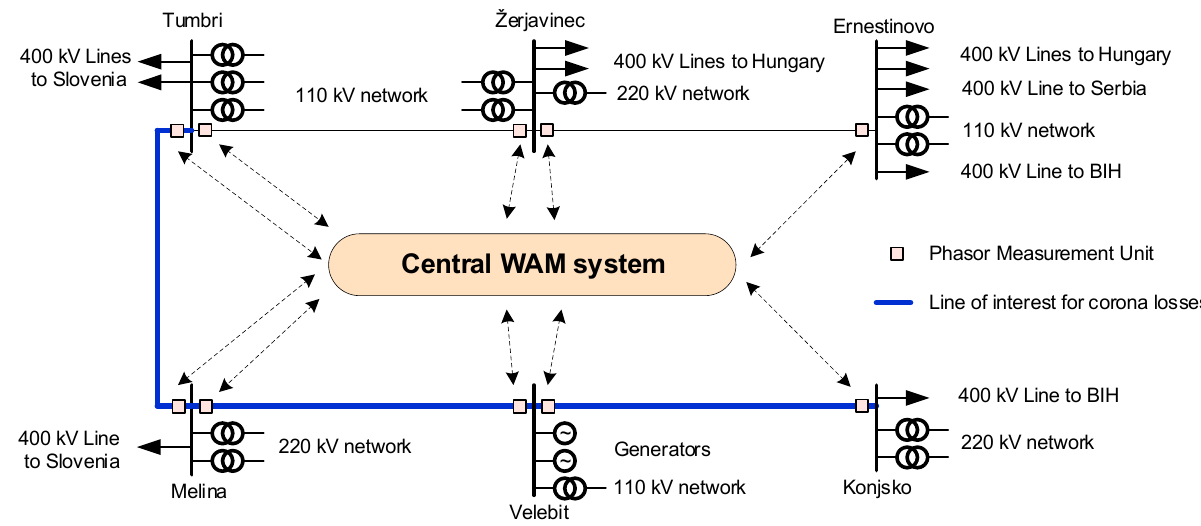
Figure 8. Block scheme of Croatian 400 kV transmission network with the marked PMU measurements.